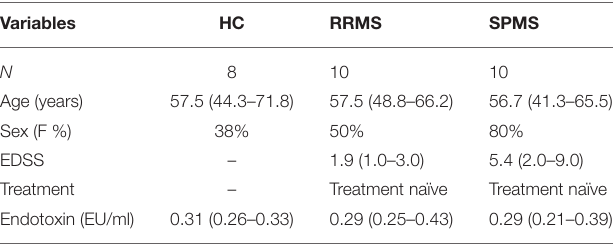
TABLE 1 | Patients and healthy controls included in the